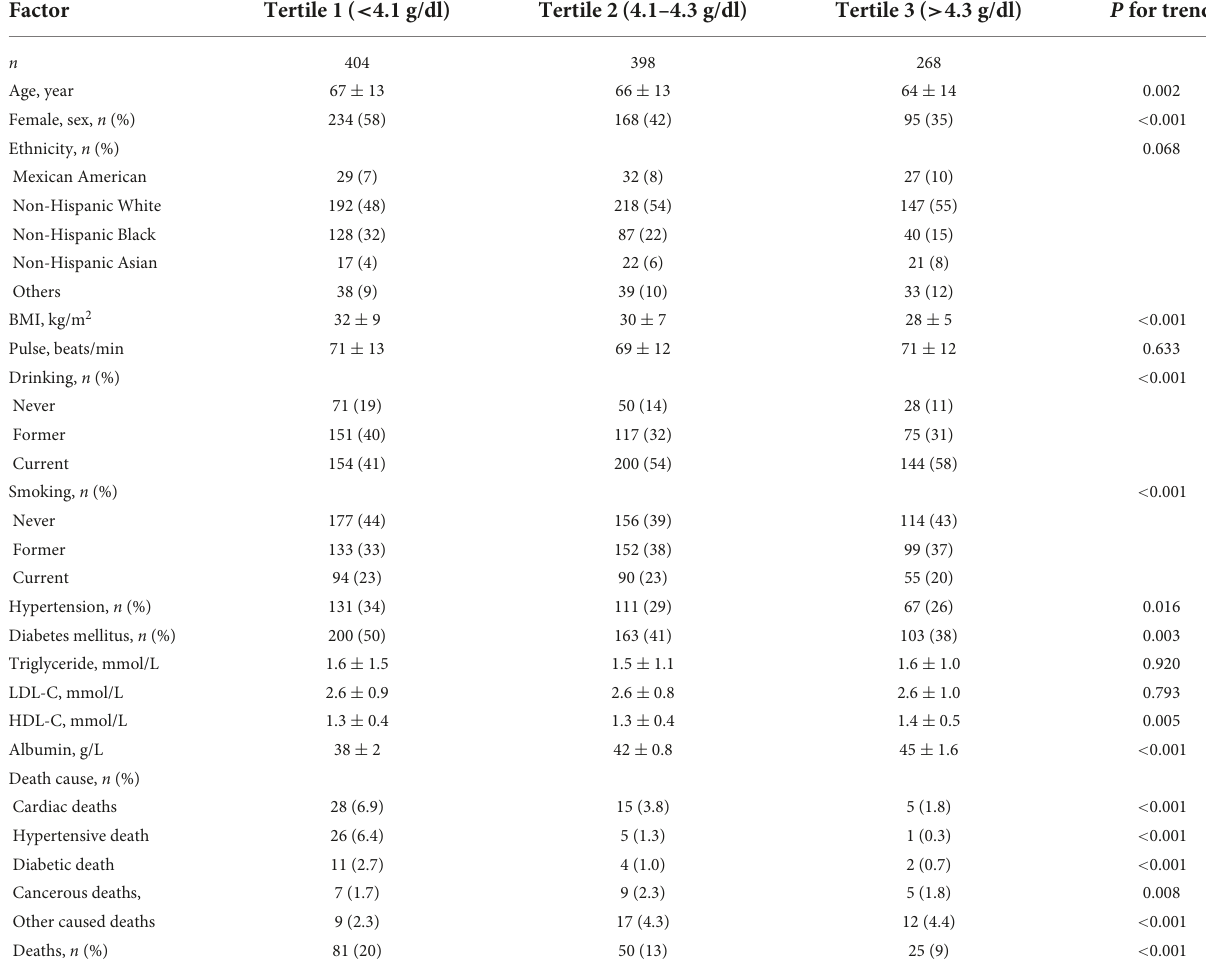
TABLE 1 Baseline characteristics of the study population stratified by albumin tertiles.